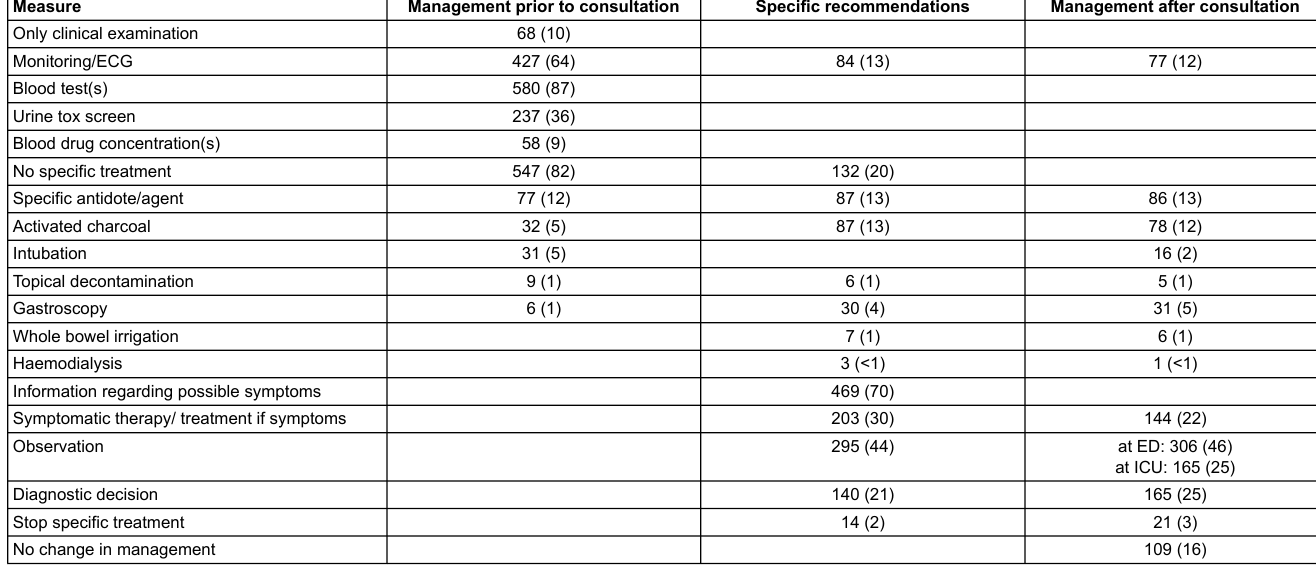
Table 3: Specific recommendations of the poison information centre and patient management before and after the consultation: n (%); N = 667.